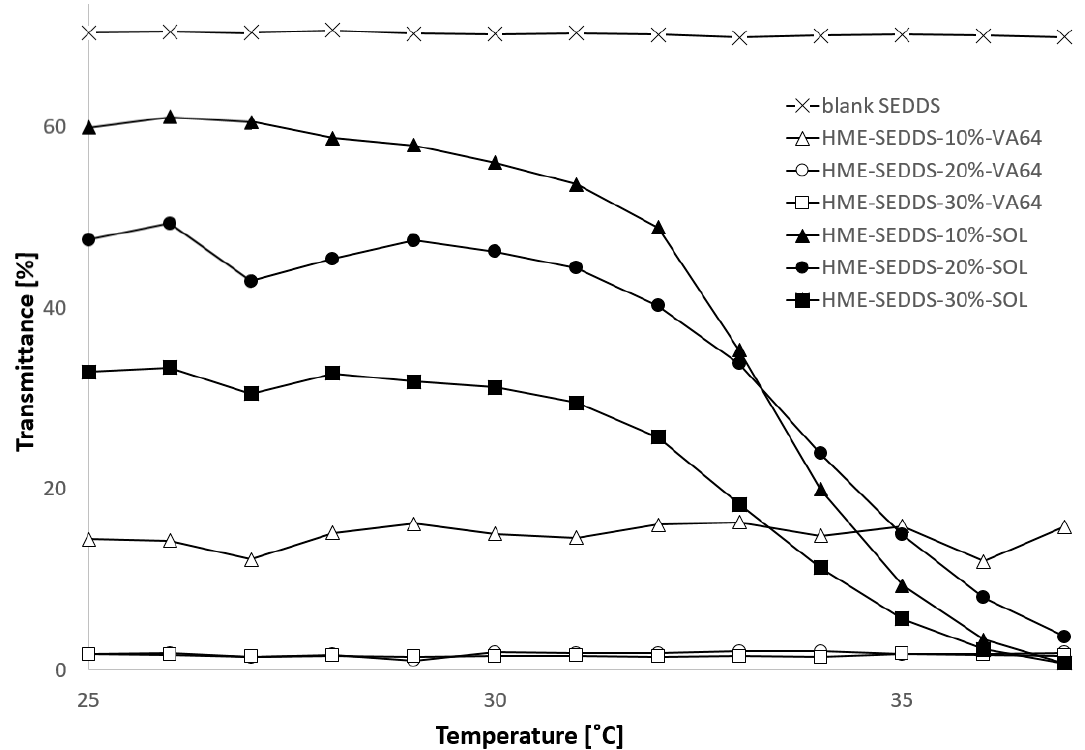
Figure 7. Transmittance change in 2% w/v emulsions of HME–SEDDSs during temperature increase from 25 °C to 37 °C. Disclaimer: HME–SEDDSs–20%–VA-64 ( ○ ) and HME–SEDDSs–30%–VA-64 ( □ ) are overlapping.